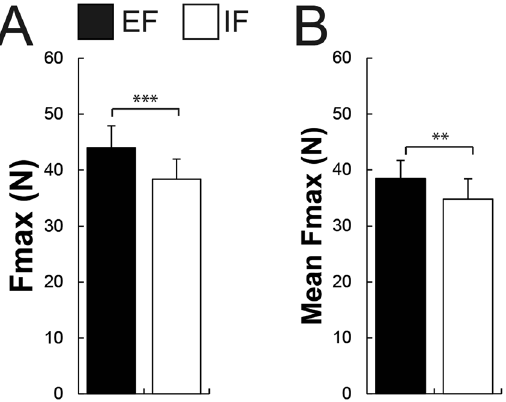
Figure 2. Shown are mean values and SEM ( n = 14) of ( A ) the force during maximal voluntary contraction (MVC, the best trial) and ( B ) the force during the 5 MVC trials averaged under both attentional focus conditions (EF vs IF). Participants could generate more force and more force when the 5 MVC trials were averaged with an EF compared to an IF. Black bars represent the external (EF) and the whites ones the internal focus of attention (IF). ** P ≤ 0.01, *** P ≤